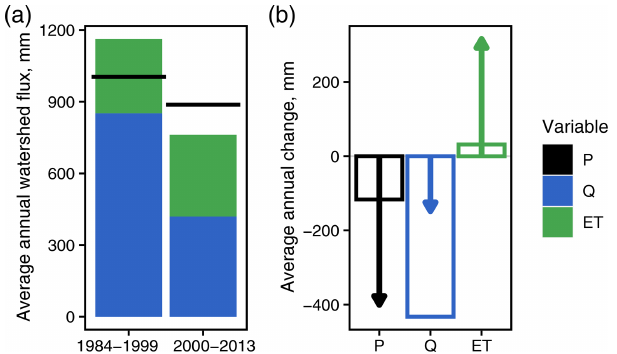
Figure 4. Water balance for the Upper Jhelum watershed. (a) Av- erage annual fluxes ( P , Q , and ET) for the periods 1984–1999 and 2000–2013. (b) Average annual change in water balance fluxes be- tween the two periods, given by the bars, with each flux estimated independently. The change in water balance fluxes estimated from water balance residuals is given by the arrows. In other words, each flux is calculated using the equation (cid:49)P − (cid:49)Q − (cid:49) ET = 0 and es- timates of the other two